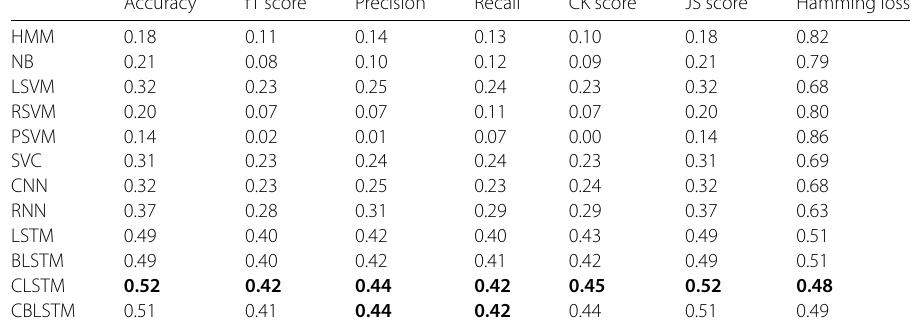
Table 7 Performance measures averaged over 38 users in a leave-one-out experiment. For all the metrics, except the Hamming loss, higher is better. CK is for Cohen’s Kappa score; JS is for Jaccard similarity Accuracy f1 score Precision Recall CK score JS score Hamming